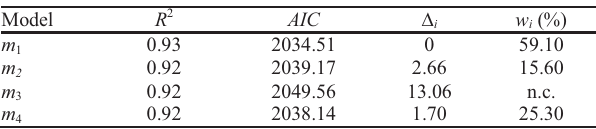
Table 4. Adjusted- R 2 , minimum Akaike’s information criterion ( AIC ), Akaike (cid:2) differences and Akaike weights ( w i candidate model using back-calculated data set. n.c. = not calculated.